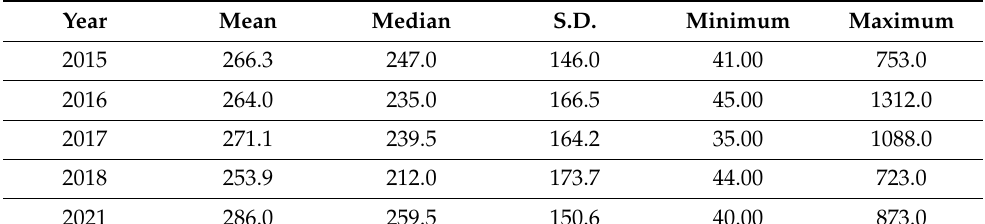
Figure 7. Total number of visitors in given years before and after COVID-19 (March to July).